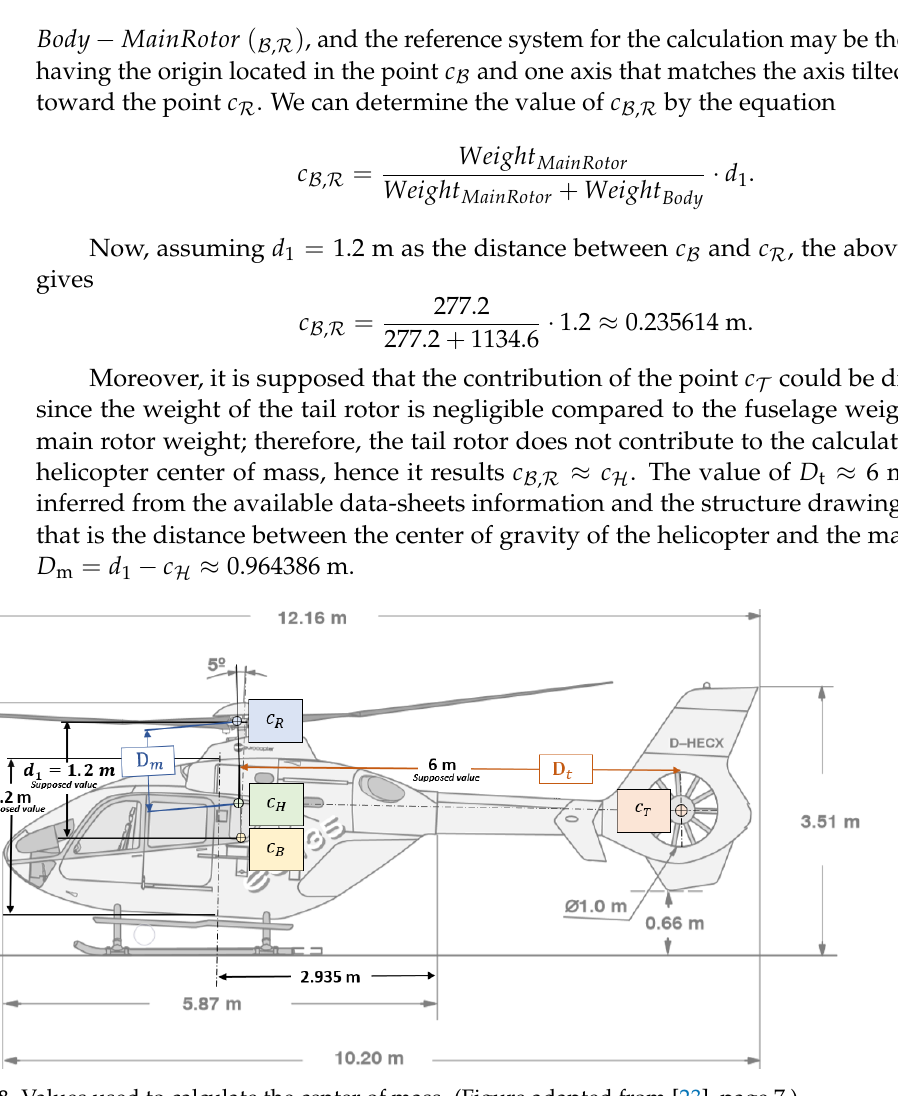
Figure 8. Values used to calculate the center of mass. (Figure adapted from [23], page 7.) Features of the engines : The EC135 P2+ helicopter type is equipped with two PW206B2 engines from Pratt and Whitney Canada Corp TM . To start engines there are two possi- bilities: manual control or automatic control. Manual control is not certificated and is normally deactivated. The automatic control is managed by the FADEC (Full Authority Digital Engine Control) that governs the starting procedure, the fuel flow and the RPMs automatically. At the start of the engines, the FADEC turns on the engines one by one until the RPMs reach the value of 98% ([1], page 437). When either the collective control or a manual switch are operated by the pilot, the FADEC increases the RPMs to 100% and the flight mode is engaged. When the altitude is higher than 4000 ft the speed is automatically increased to 104%, because the air density decreases. Moreover, to avoid loss of thrust when the collective angle is varied, in the main rotor (pitch) or in the tail rotor (yaw), the FADEC fixes the engine power to maintain the desired speed. The characteristics of the engines are summarized in Table